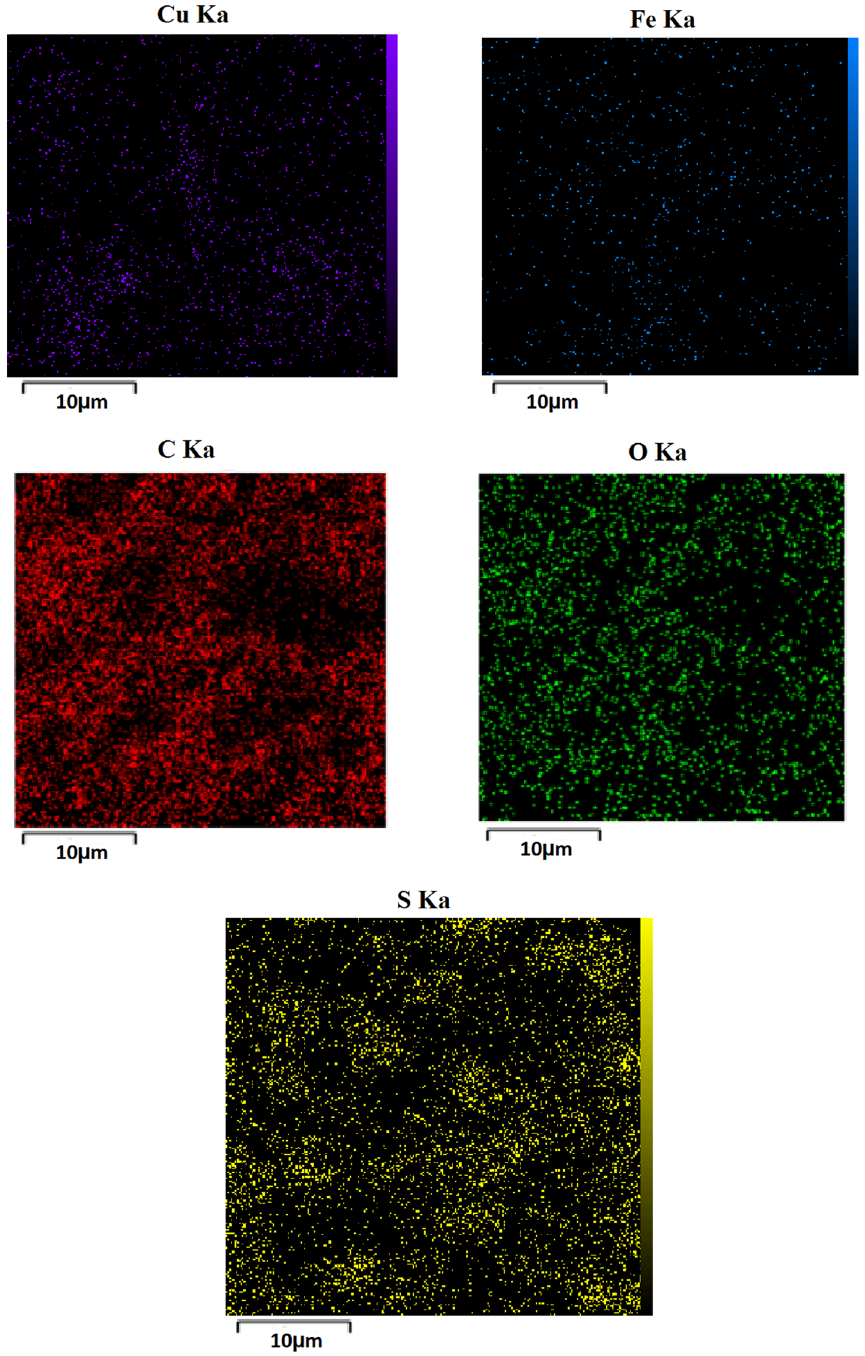
Figure 5. Elemental mapping of Fe 3 O 4 -PTMS-NAS@Cu